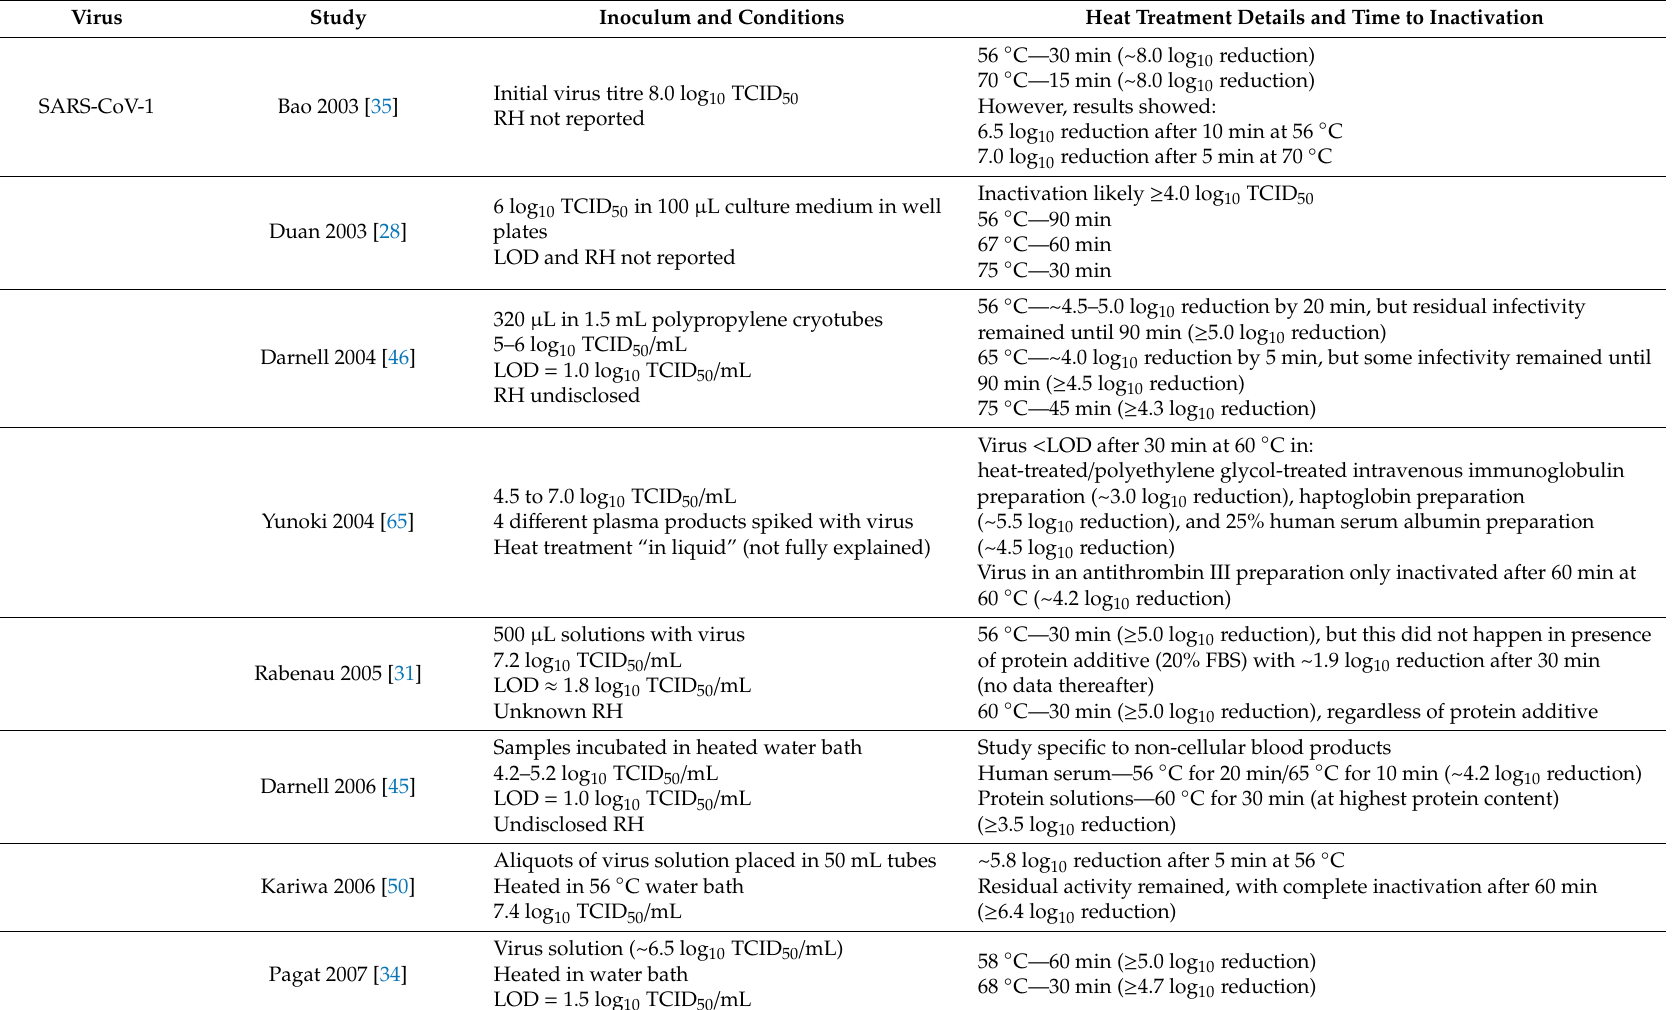
Table 5. Studies reporting on the e ffi cacy of heat treatment against SARS-CoV-1 and